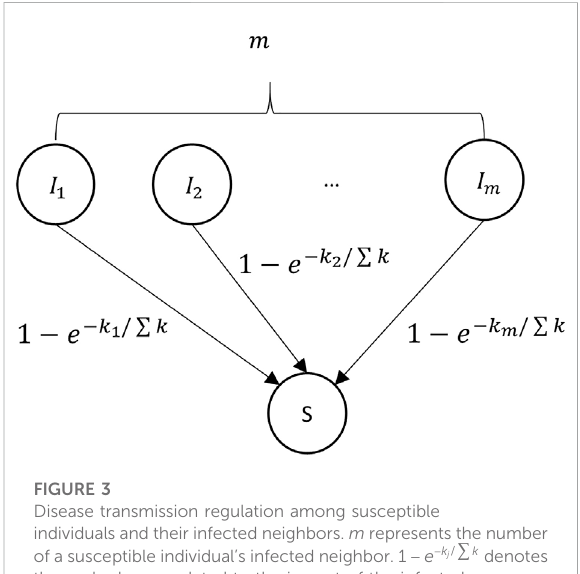
FIGURE 3 Disease transmission regulation among susceptible individuals and their infected neighbors. m represents the number of a susceptible individual ’ s infected neighbor. 1 − e − k j / (cid:1) k denotes the node degree related to the impact of the infected neighbor j .